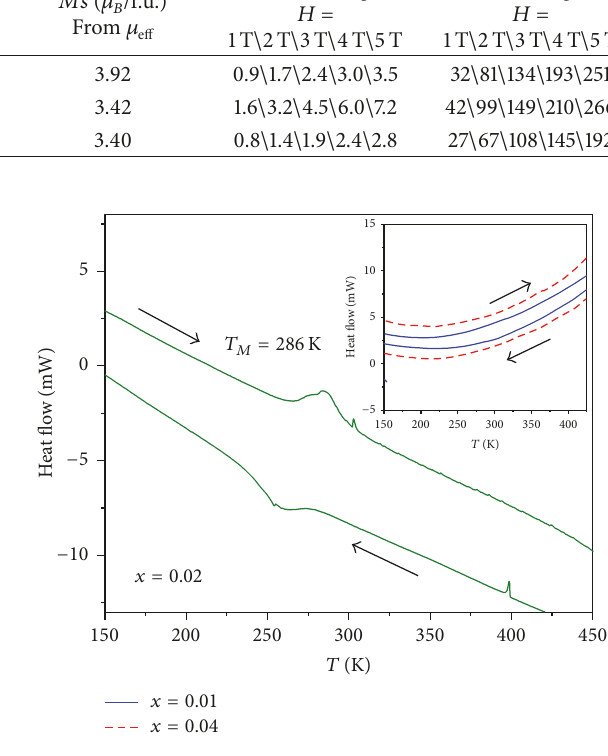
Figure 4: DSC heat flow curves (endothermic and exothermic peaks) as a function of temperature measured at the rate of 30 K/min during heating and cooling for the compound with 𝑥 = 0.02. Inset: DSC heat flow curves for 𝑥 = 0.01 and 𝑥 = 0.04. The arrows indicate the heating and cooling cycles.